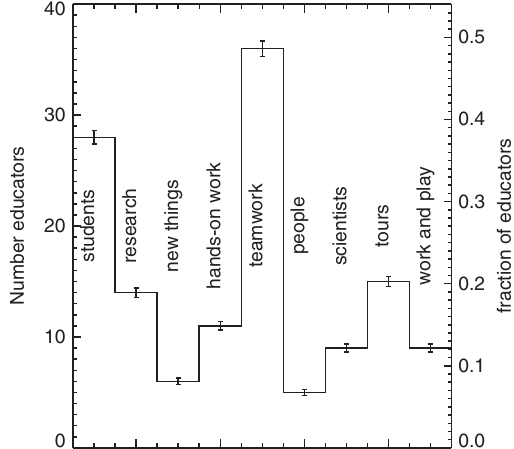
FIG. 3. Number (left axis) and fraction (right axis) of educators ’ responses to the question, “ What was the best part of the trip? ” The specific values are listed in Table I. Nearly half the teachers cite teamwork as the best thing about the trips; see the text for additional